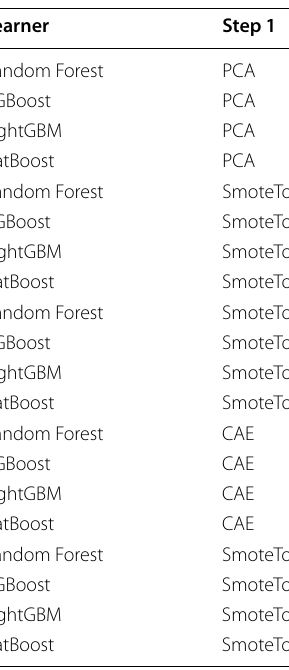
Table 9 Performance scores for SMOTE